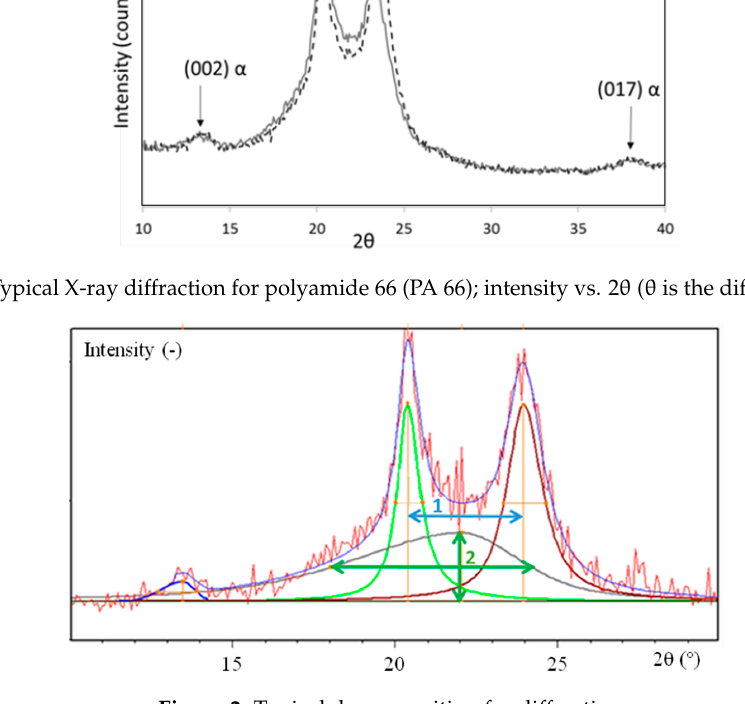
Figure 2. Typical decomposition for diffraction.